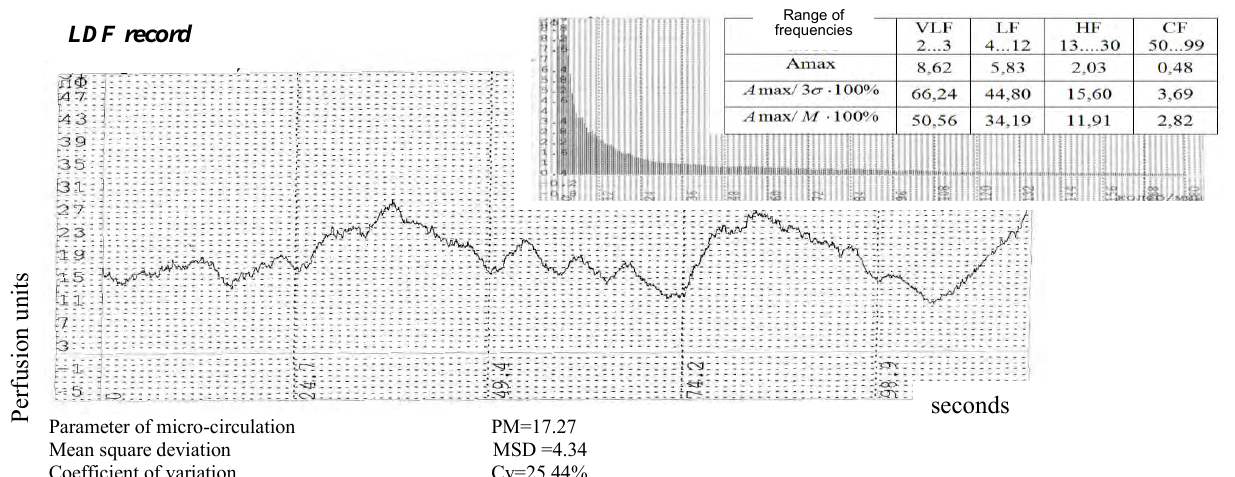
Fig.5. Daily monitoring of LDF record of 17 years old girl with standard type of micro-circulation at 11 p.m. At 4 p.m. metabolic component of vasomotor activity plays substantial role in modulation of tissue flow’s oscillations. At 7 p.m. contribution of LF oscillations reduces. Contribution of HF oscillations increases. Here we see clear compensatory increasing of breathing rhythm, which plays passive role in modulations of tissue blood flow. As 11 p.m. contribution of VLF-oscillations, LF- and HF- oscillations corresponded to values of 8 a.m. In comparison with morning hours it is higher by